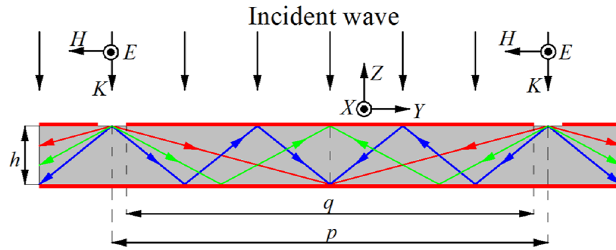
Fig. 5. The schematic diagram of the standing wave